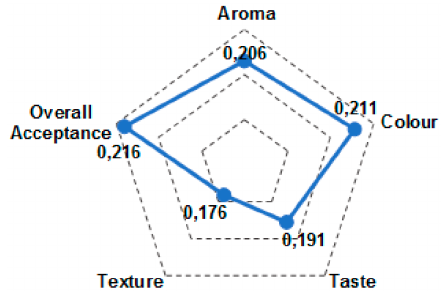
Figure 5 Radar diagram of criteria weight